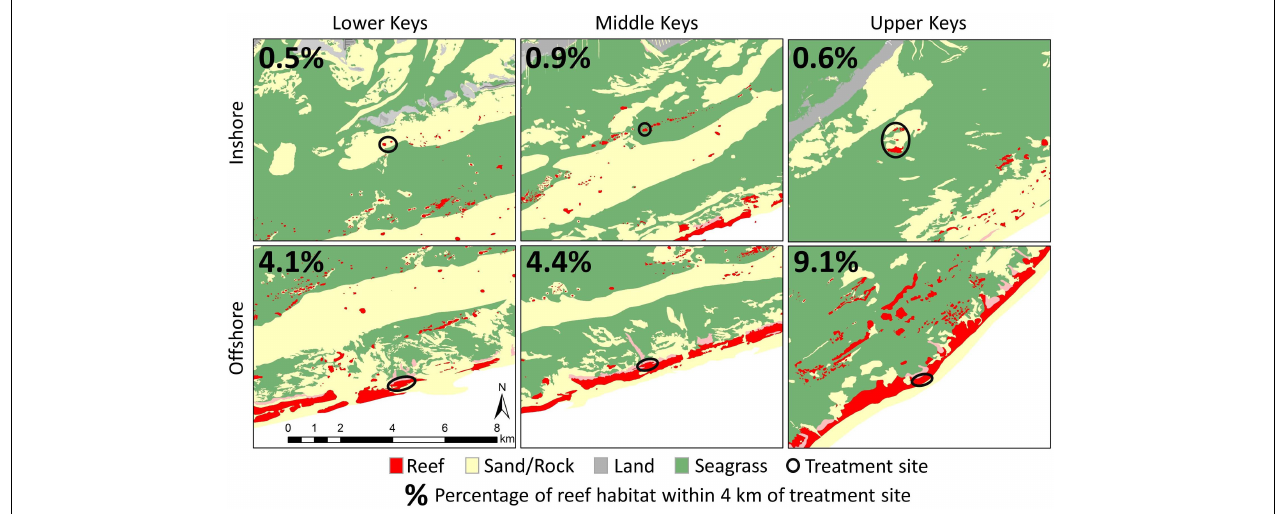
FIGURE 7 | Habitat maps surrounding six treatment sites (inshore and offshore within each region) indicating the relative isolation of inshore sites from surrounding reef environments compared to offshore sites. Red indicates reef environment, and black circles indicate treatment sites. All maps are to the same scale. Percentage values in each map indicate the percentage of habitat within a 4 km radius of each site that is reef habitat. Habitat classifications are derived from the Florida Unified Reef Map.